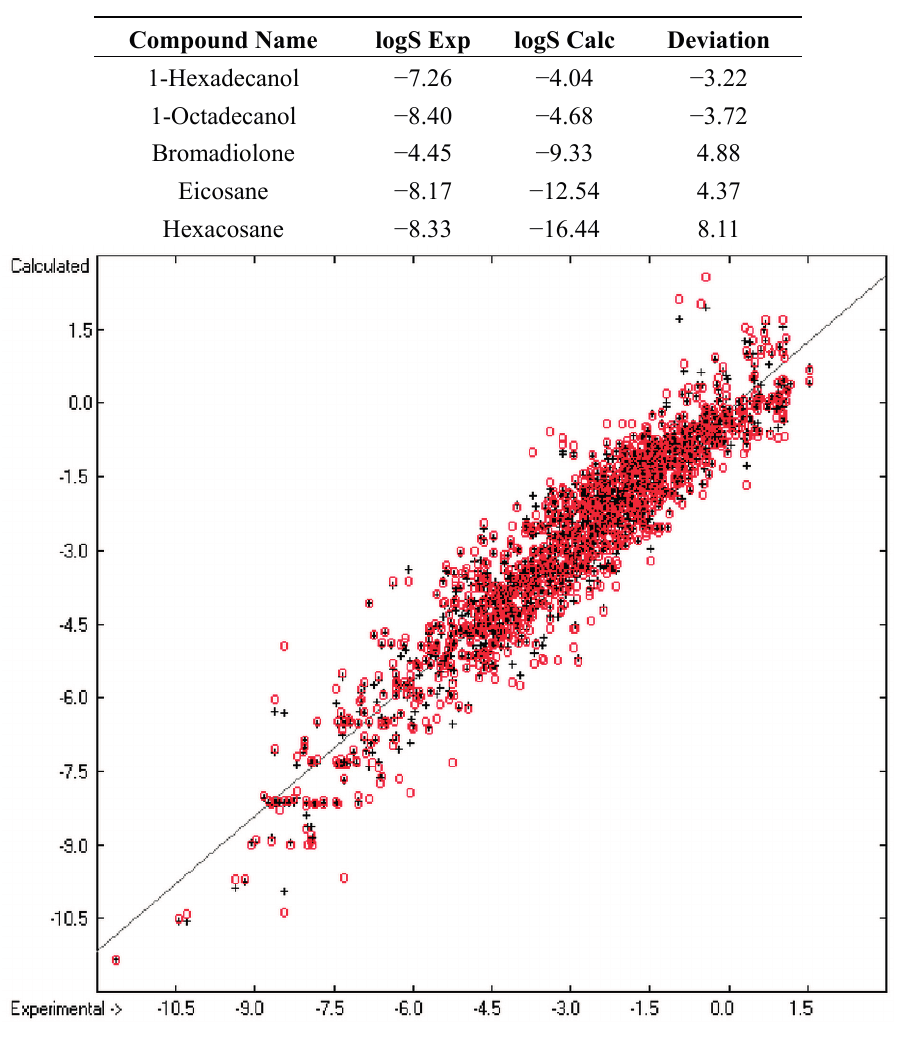
Table 12. Molecules with extreme LogS Deviations.